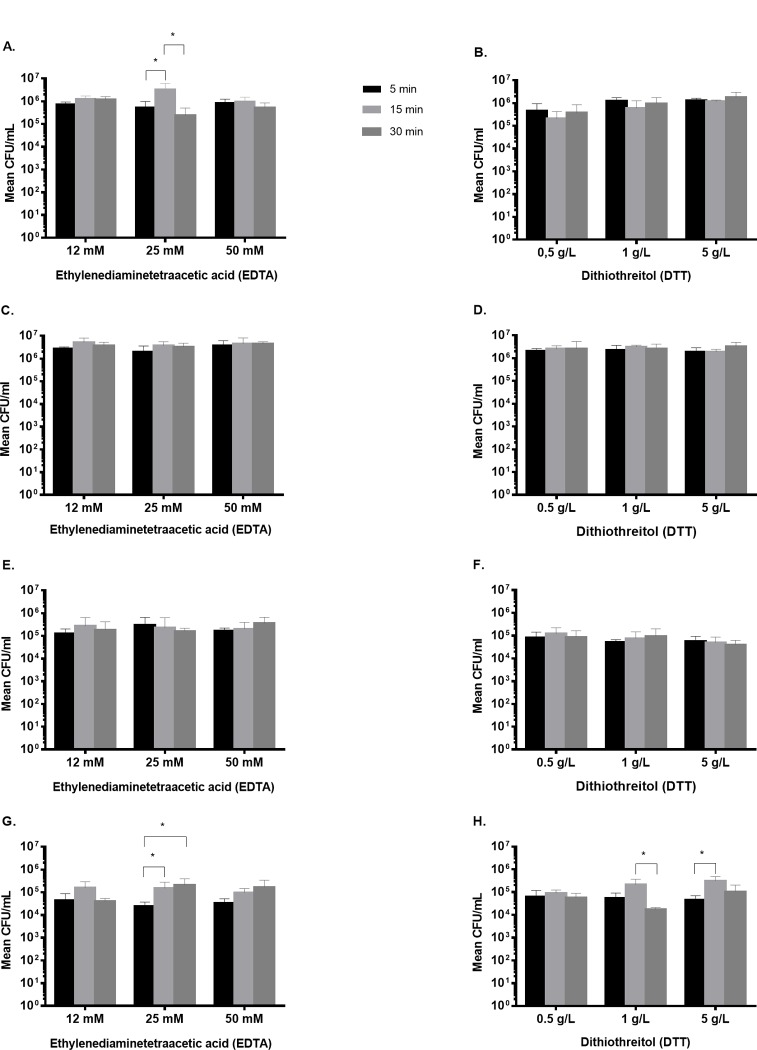
Bacterial biofilm dislodged after treatment with different concentrations of chemical agents at different time points.S. epidermidis biofilm (A) EDTA, (B) DTT. S. aureus biofilm (C) EDTA, (D) DTT; E. coli biofilm (E) EDTA, (F) DTT; P. aeruginosa biofilm (G) EDTA, (H) DTT. Mean values are shown, error bars represent standard deviation. * Statistically significant difference (p < 0.05).